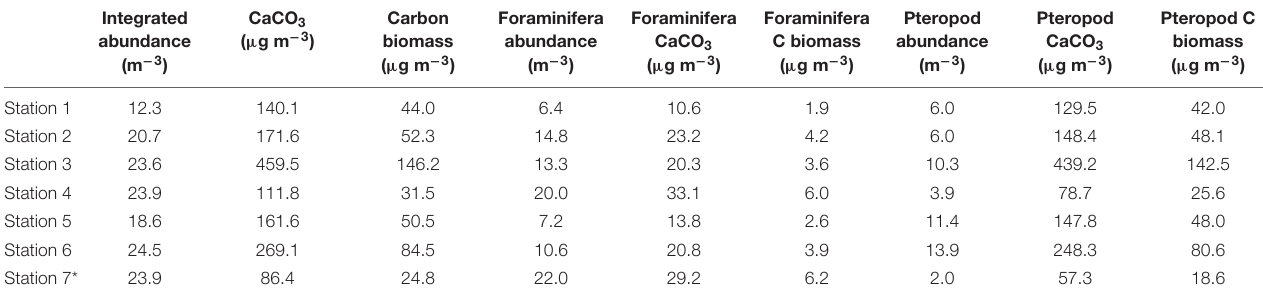
TABLE 5 | Integrated (upper 100 m) absolute abundance (m − 3 ) and derived CaCO 3 standing stocks ( µ g m − 3 ) and carbon biomass ( µ g m − 3 ) and the contribution from planktic foraminifera and pteropods. Integrated abundance